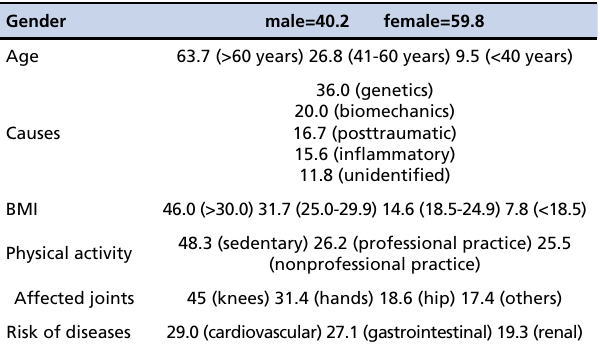
Table 1 - Epidemiological data (%) for OA in Brazil. Gender male=40.2